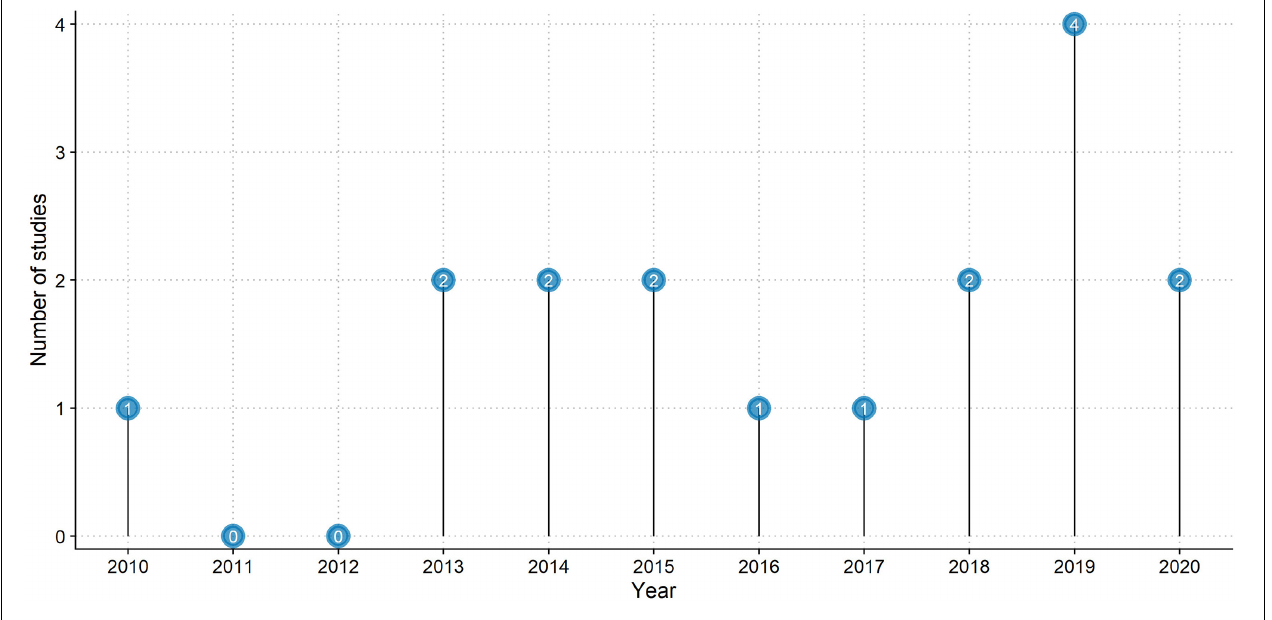
FIGURE 2 | Studies published per